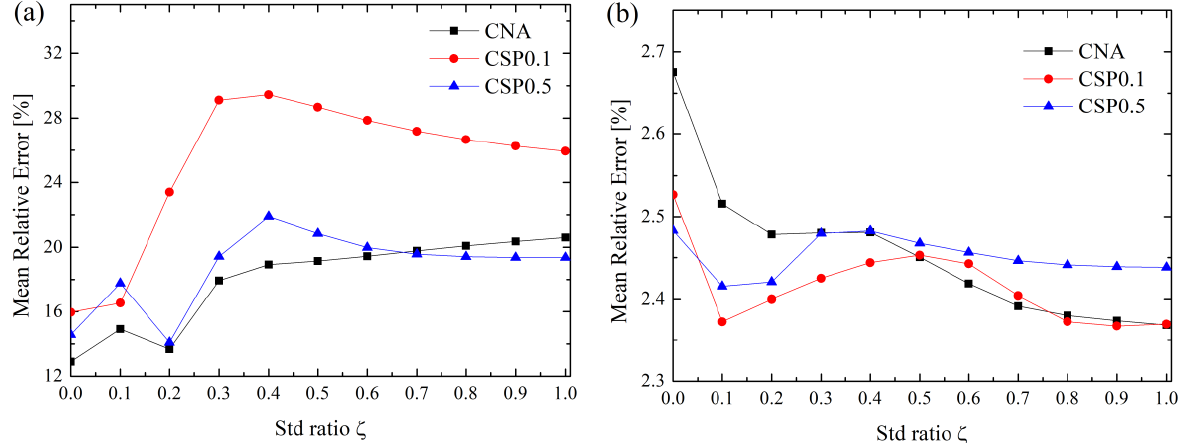
Figure 3. MRE of Cu GBs for three methods of selecting GB atoms ( a ) <110> and ( b ) <100> tilt axis. Results of Al and Ni are shown in Figures S15 and S20 in Supplementary Material.